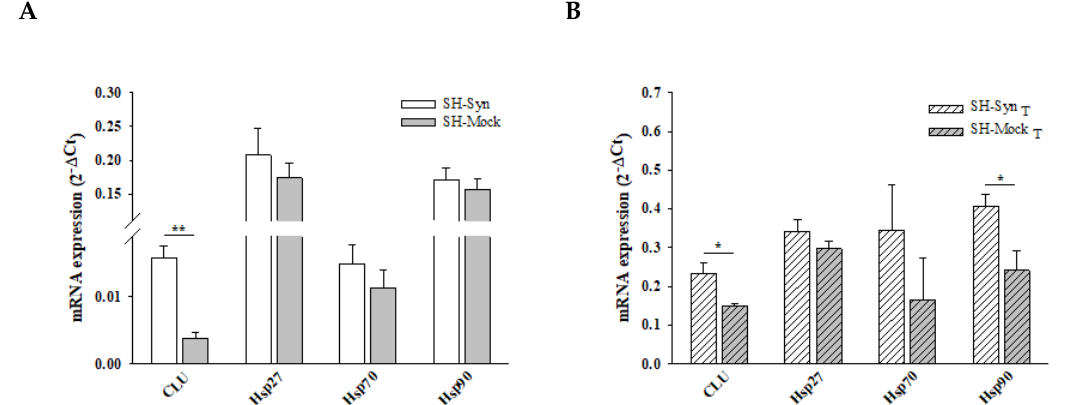
Figure 4. Chaperones mRNA level in SH-Syn and SH-Syn T . ( A ) CLU, Hsp27, Hsp70, and Hsp90 mRNA quantification by qPCR in SH-Syn and SH-Mock. ( B ) CLU, Hsp27, Hsp70, and Hsp90 mRNA quantification by qPCR in SH-Syn T and SH-Mock T . Data are presented as the mean ± SD of three independent experiments, each performed in duplicate. Data were analyzed by a Mann – Whitney Rank Sum Test (* p < 0.05, ** p < 0.001).